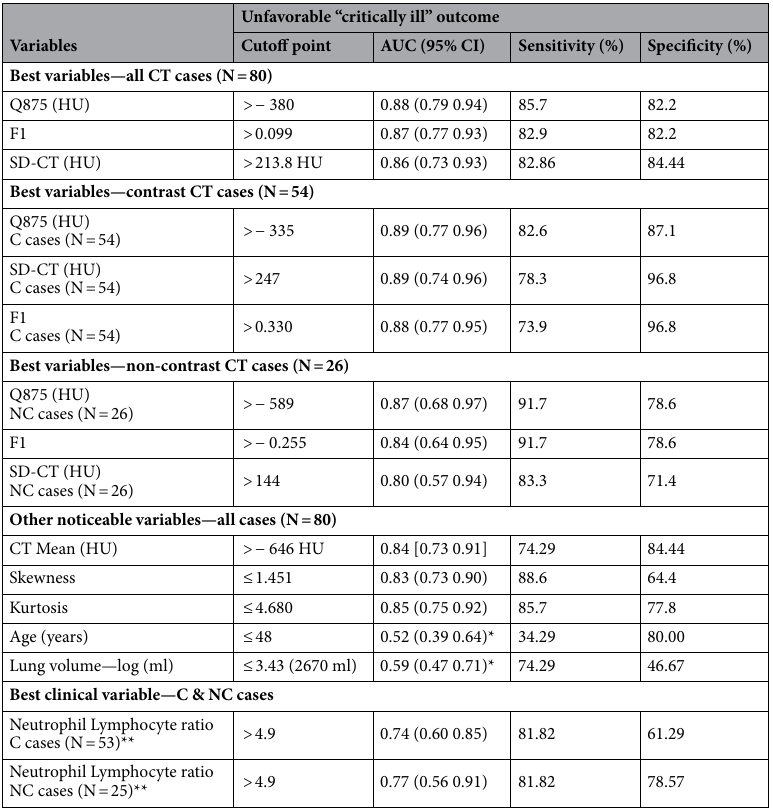
Table 1. Univariate (ROC) Analysis. Best variables (all cases, and cases with and without contrast) and other noticeable variables (Age, Lung volume and neutrophil lymphocyte ratio NLR). Cutoff points were calculated using Youden index. 95% confidence intervals. *Non-significant P value with test on AUC for continuous variables. **1 outlier removed. NC non contrast, C contrast, ROC receiving-operating